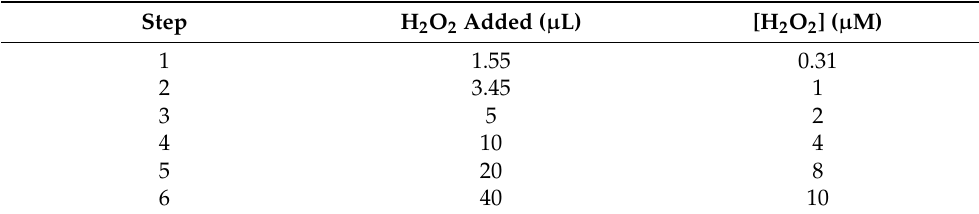
Table 1. Volume 2 mM H 2 O 2 added during each calibration step, with a resultant final concentration of H 2 O 2 in 10 mL